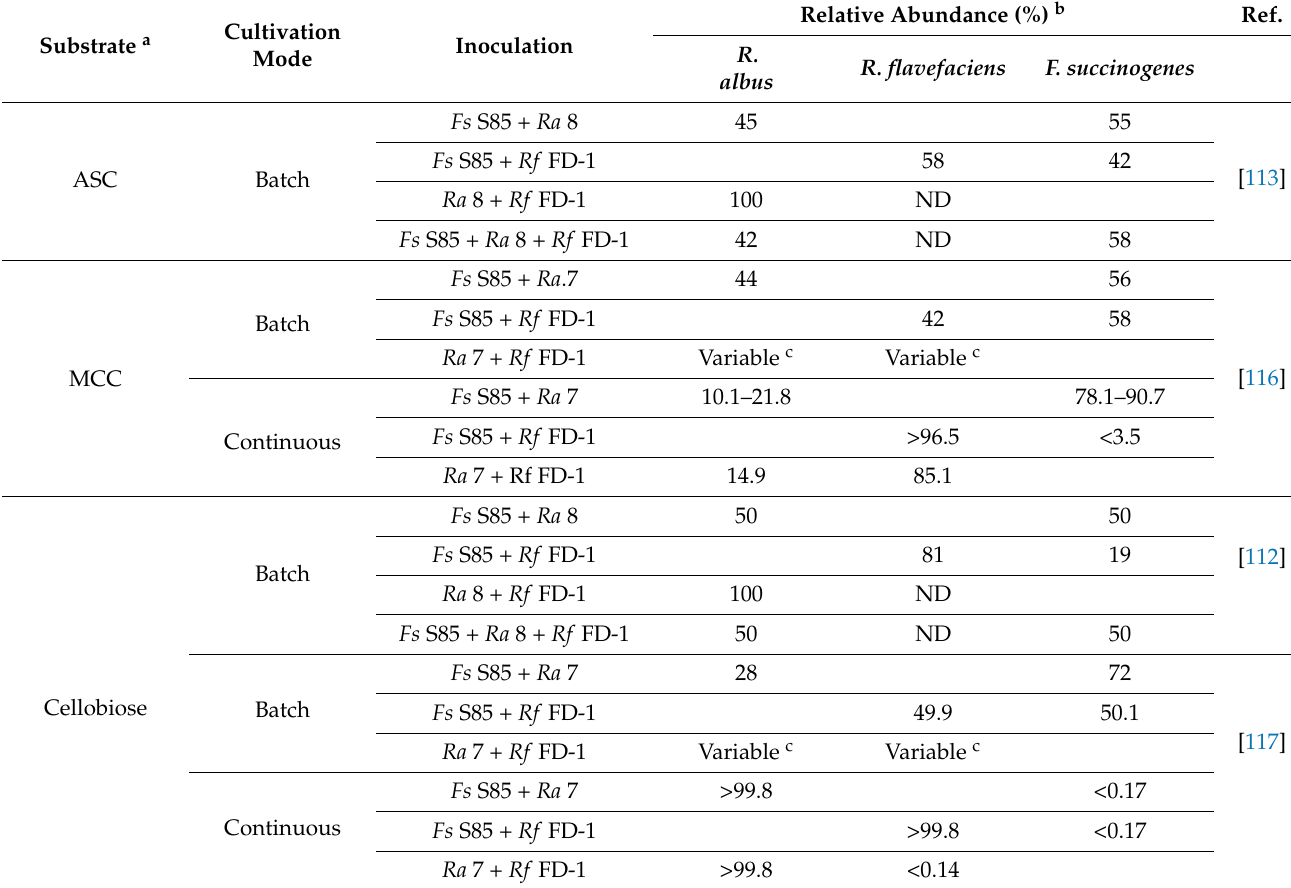
Table 5. Outcome of competition experiments among the three predominant ruminal cellulolytic bacteria in batch (substrate-excess) or continuous (substrate-limited)